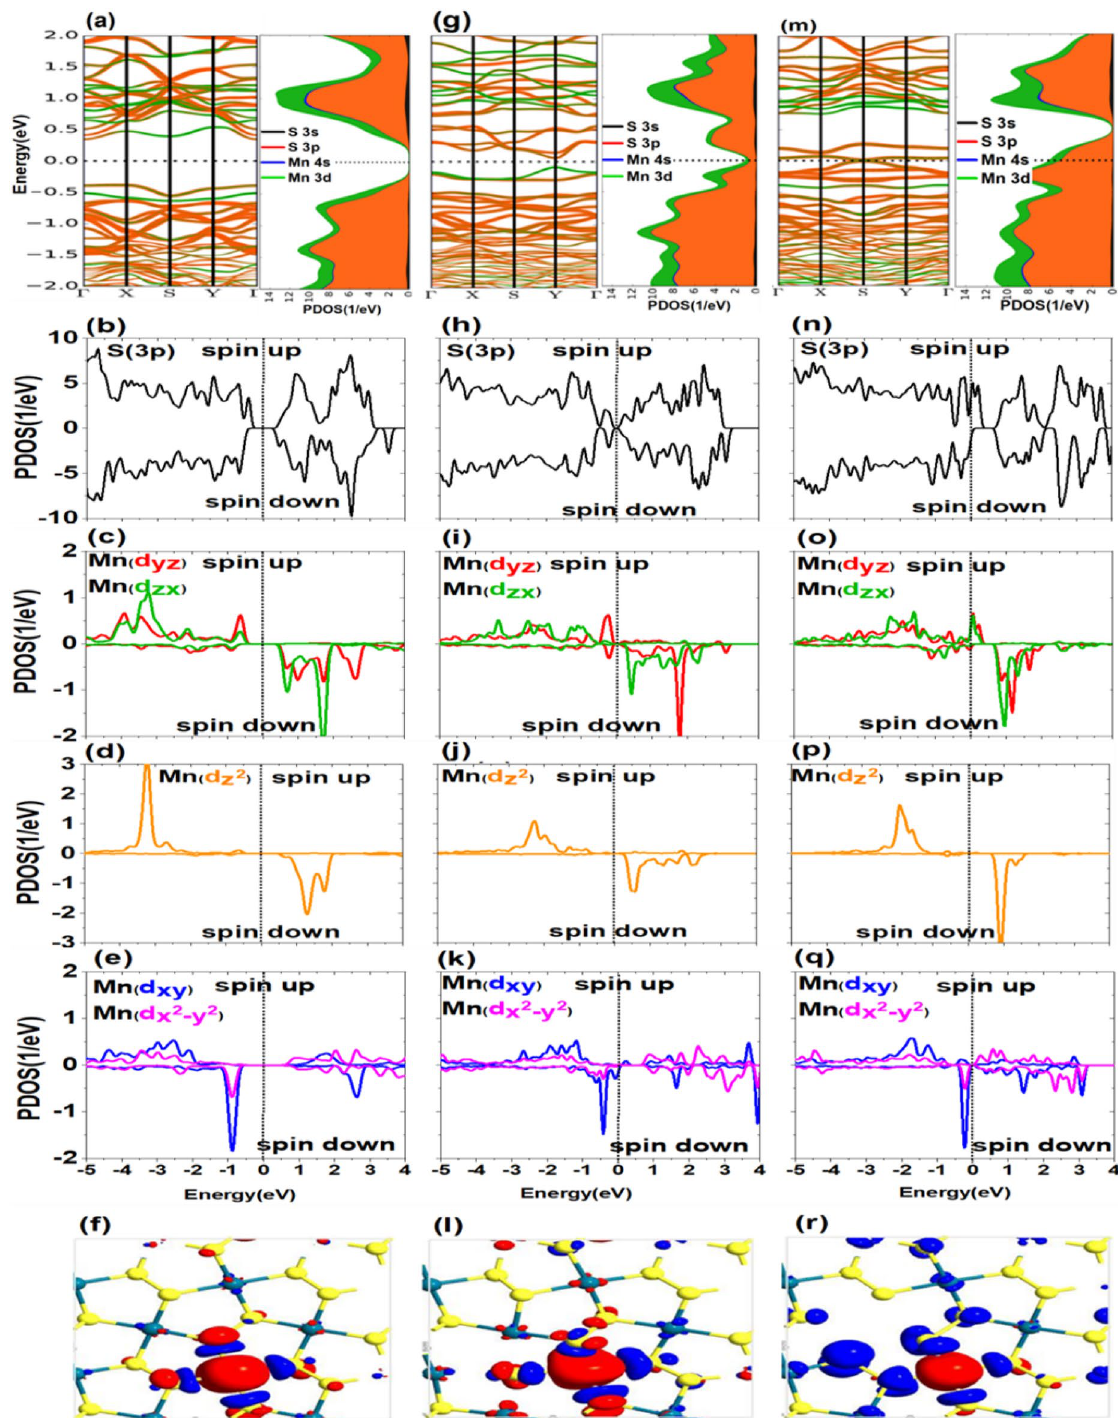
Figure 3. ( a–f ) Band structure and PDOS of p and d orbitals and spin density difference in the presence of transition metal impurity (Mn), ( g–l ) in the presence of the S atom vacancy defect, and ( m–r ) in the presence of the Pd atom vacancy